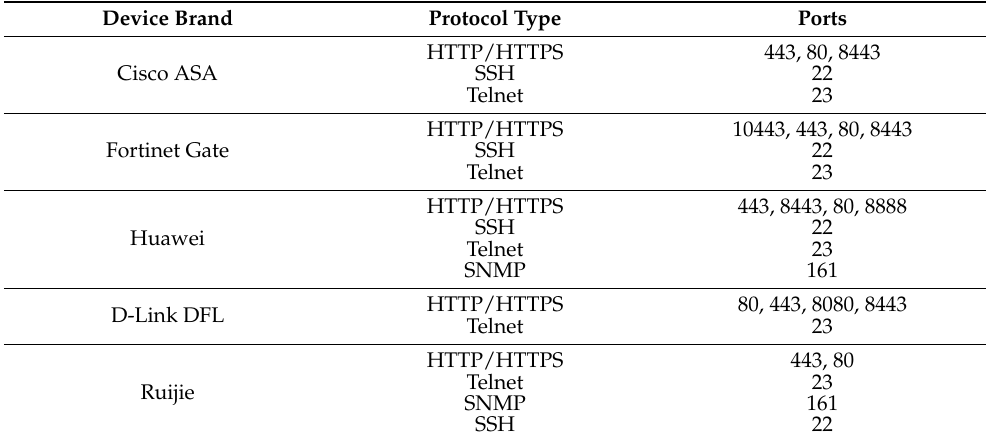
Table A2. Special Port For Firewall.